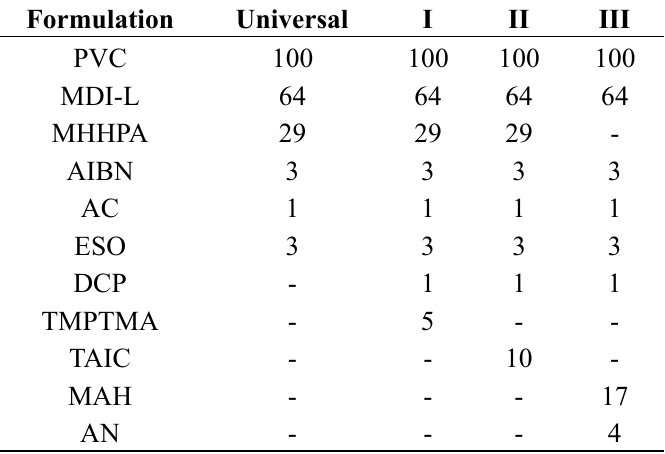
Table 5. Formulas of cross-linked PVC foam plastics.